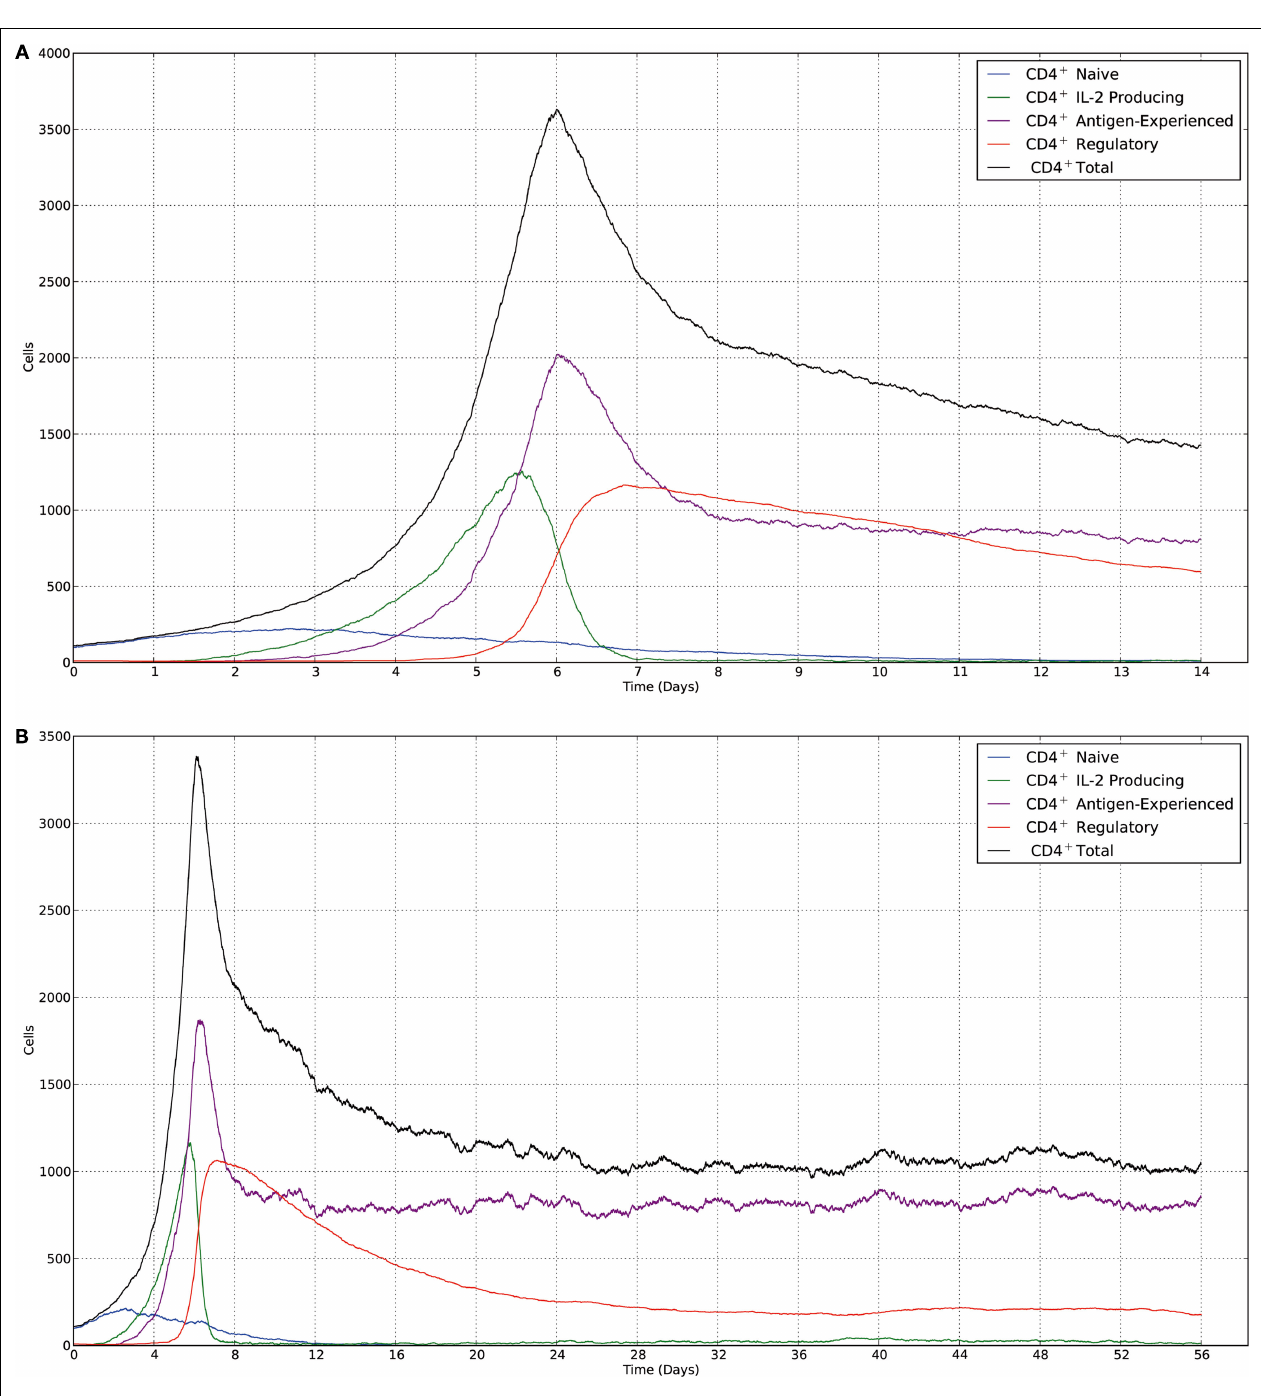
Figure 2 .There is a higher degree of noise at equilibrium for memory cells, which is due to memory cells repeatedly receiving antigen-mediated signals to become IL-2-producing, then reverting back to a non-IL-2-producing